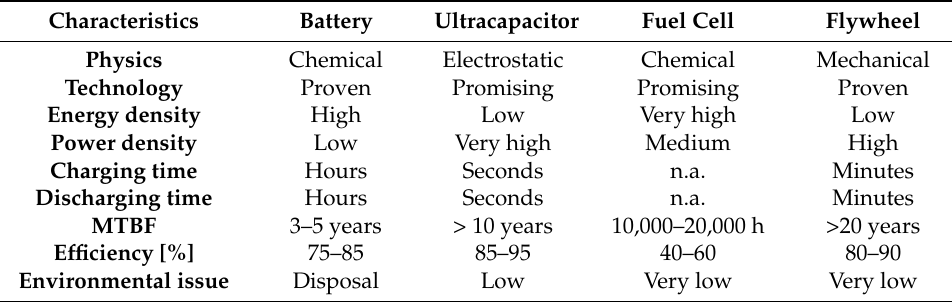
Table 10. Energy Storage System Specifications.